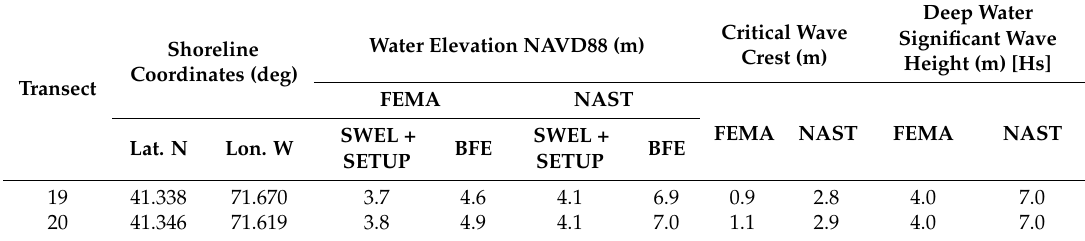
Table 2. Comparison of the water elevation (NAVD88, m), critical wave crest height (m) and deep water significant wave height (m) at the intersection of the transect and shoreline for transects #19 and